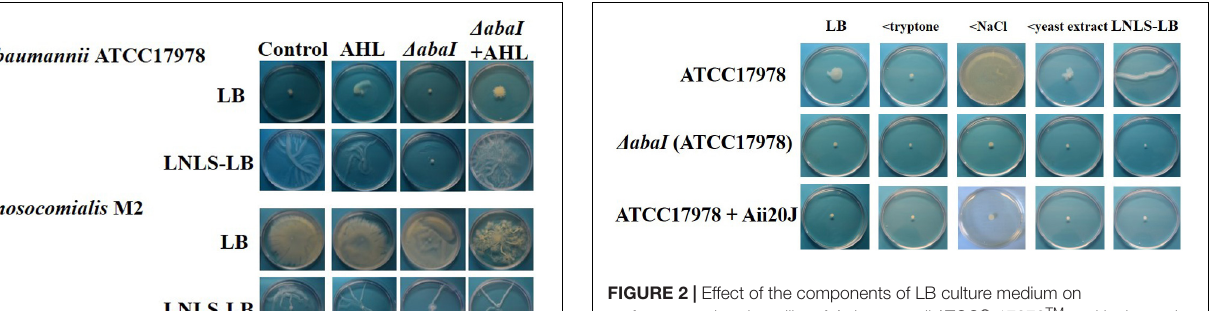
FIGURE 2 | Effect of the components of LB culture medium on surface-associated motility of A. baumannii ATCC R (cid:13) 17978 TM and its isogenic mutant (cid:49) abaI , on different media plates with 0.25% Eiken agar. The effect of the QQ enzyme Aii20J (20 µ g/mL) on A. baumannii ATCC R (cid:13) 17978 TM was also evaluated. Plates were incubated at 37 ◦ C for 14 h and images are representative of three independent experiments carried out carried out with three replicates per condition ( < tryptone: LB with reduced tryptone concentration, < NaCl: LB with reduced NaCl concentration, < yeast extract: LB with reduced yeast extract concentration, and LNLS-LB: low-nutrient low-salt